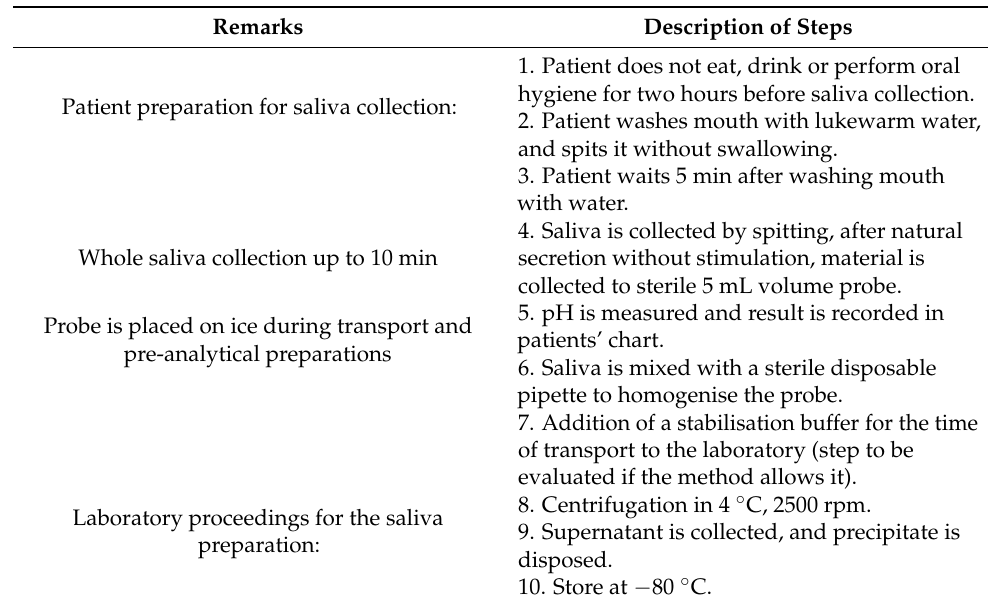
Table 3. Good laboratory practice for unstimulated saliva collection and patient preparation, based on latest literature and WHO